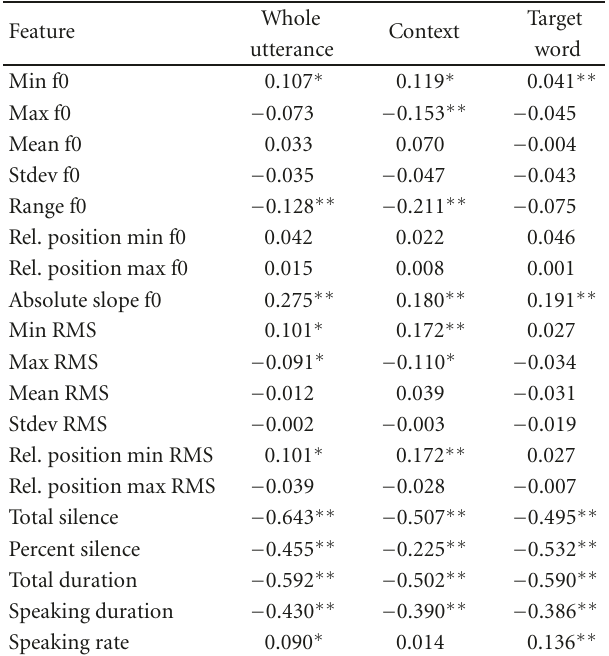
Table 5: Correlations between mean perceived rating and prosodic features for whole utterances, contexts, and target words, N = 480 (note: ∗ indicates significant at P < . 05; ∗∗ indicates significant at P < .